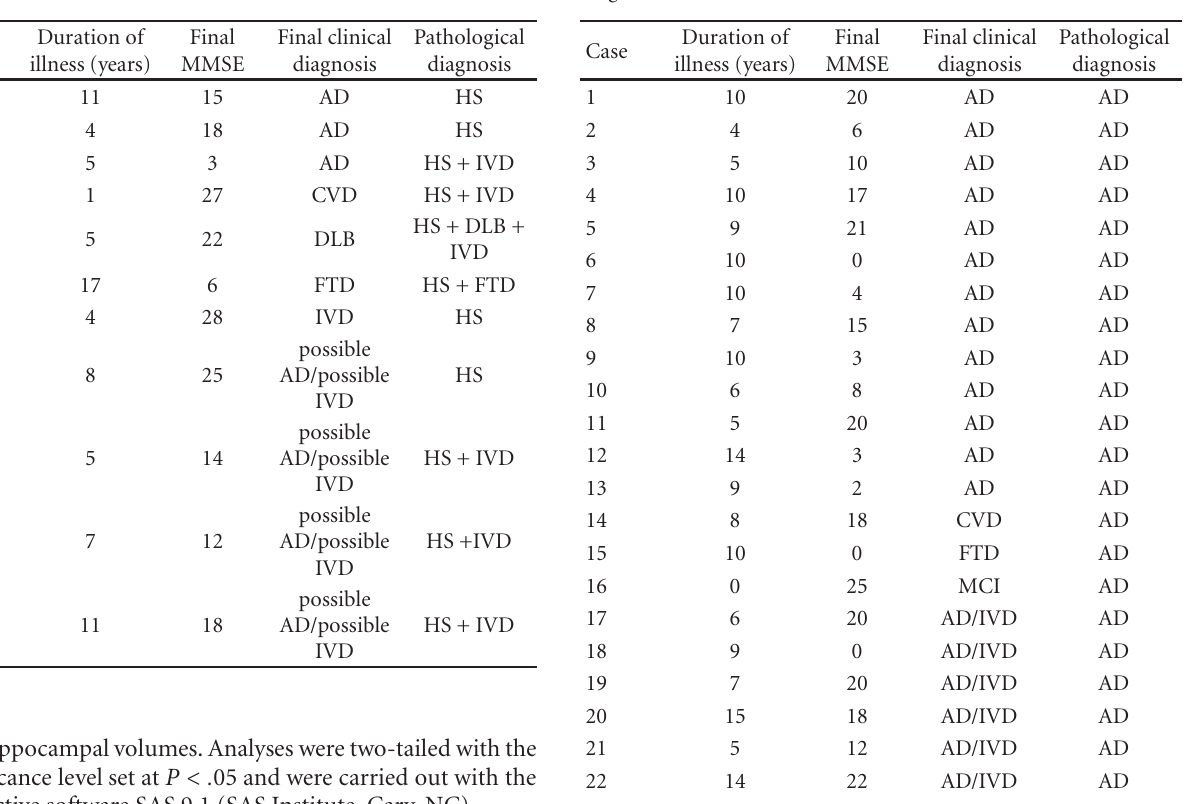
Table 2: Dementia severity, clinical diagnoses, and pathological diagnoses for HS cases.